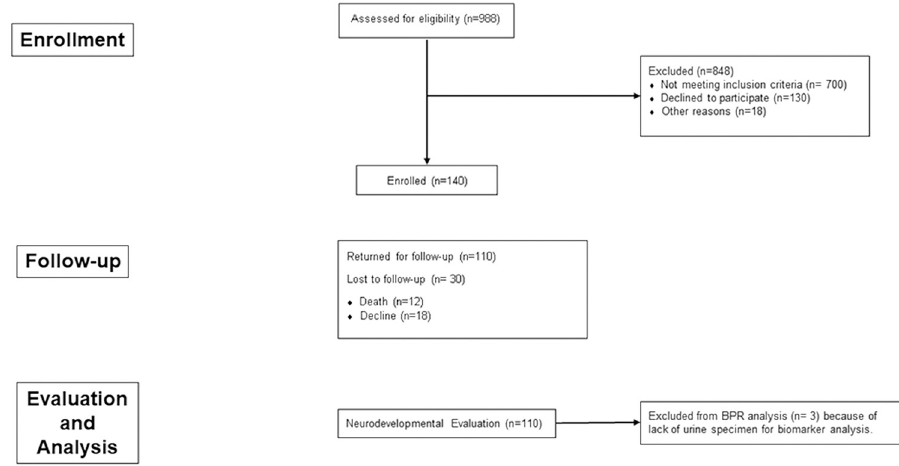
Fig 1. Study enrollment and evaluation